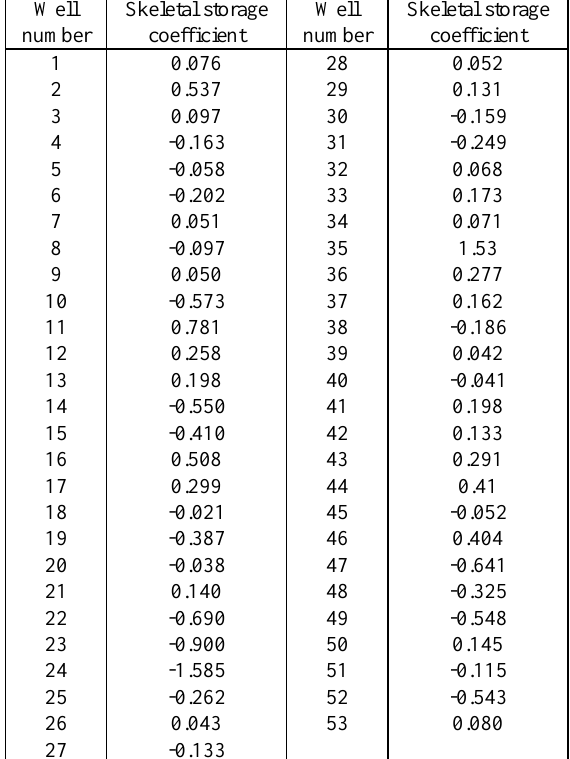
Table 3. Values calculated for skeletal storage coefficient at wells location in over the subsidence